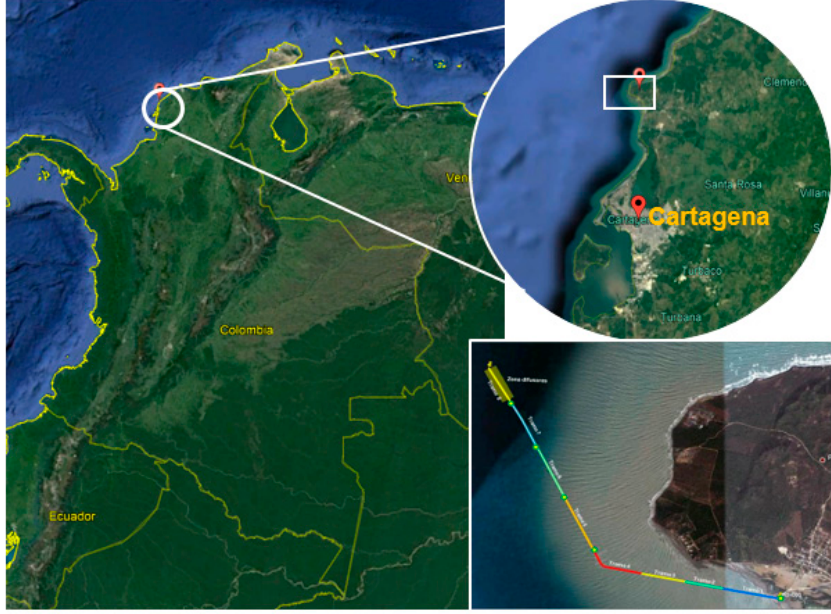
Figure 1. Location of the submarine outfall of Cartagena de Indias. Source: Google Earth.